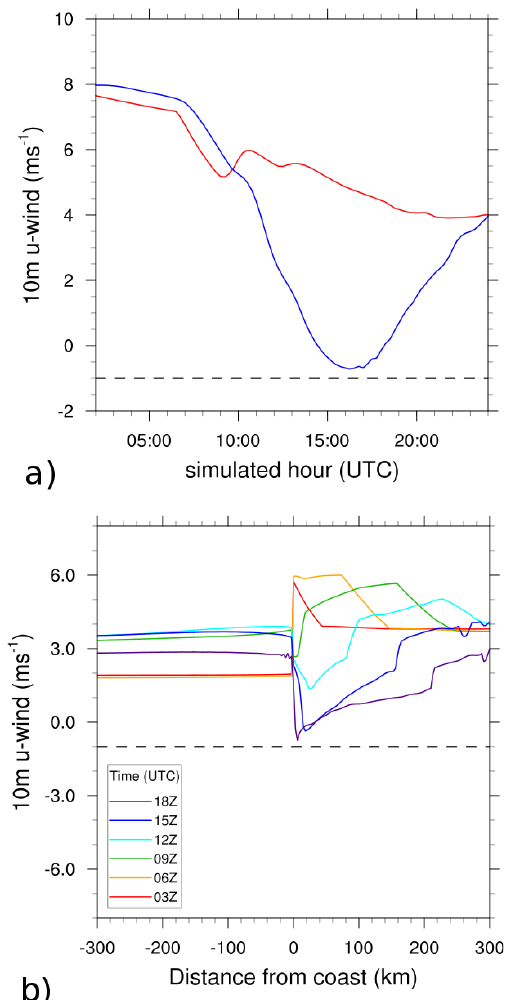
Fig. 12. (a) 10m u-wind speed for locations on the coastline (red) and 30km offshore (blue) for a single coast pure sea breeze simu- lated with 8ms − 1 offshore gradient wind. (b) 10m u-wind speed across the model domain at 03:00 (red), 06:00 (orange), 09:00 (green), 12:00 (cyan), 15:00 (blue) and 18:00 (purple) UTC. The dashed line represents the 1ms − 1 offshore wind speed threshold required for diagnosing a sea breeze. In all simulations, the YSU PBL scheme was used in conjunction with a SST of 287K.